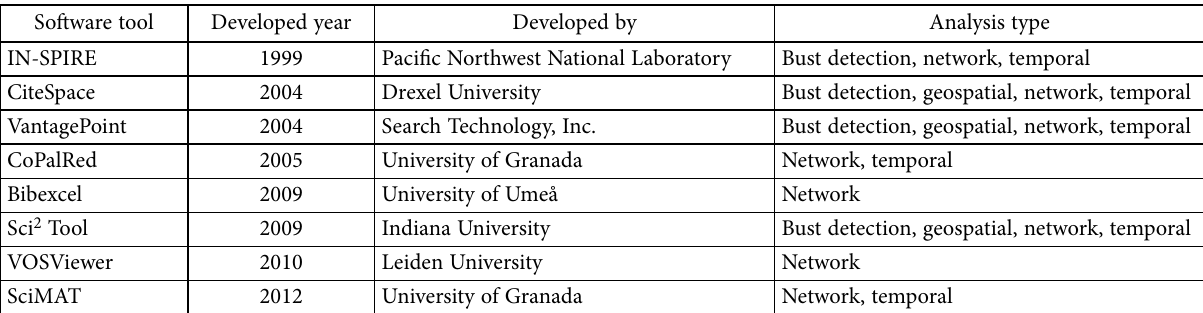
Table 1. A comparison of main bibliometric